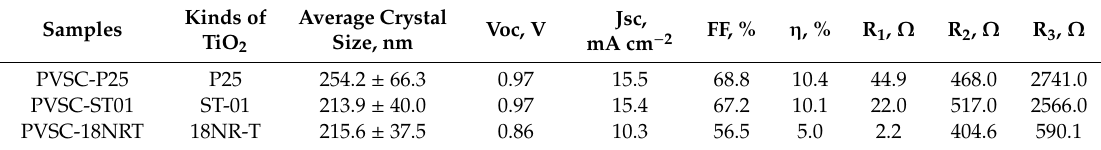
Table 4. Absorption of lead ions on different TiO 2 determined by ICP-OES analysis.